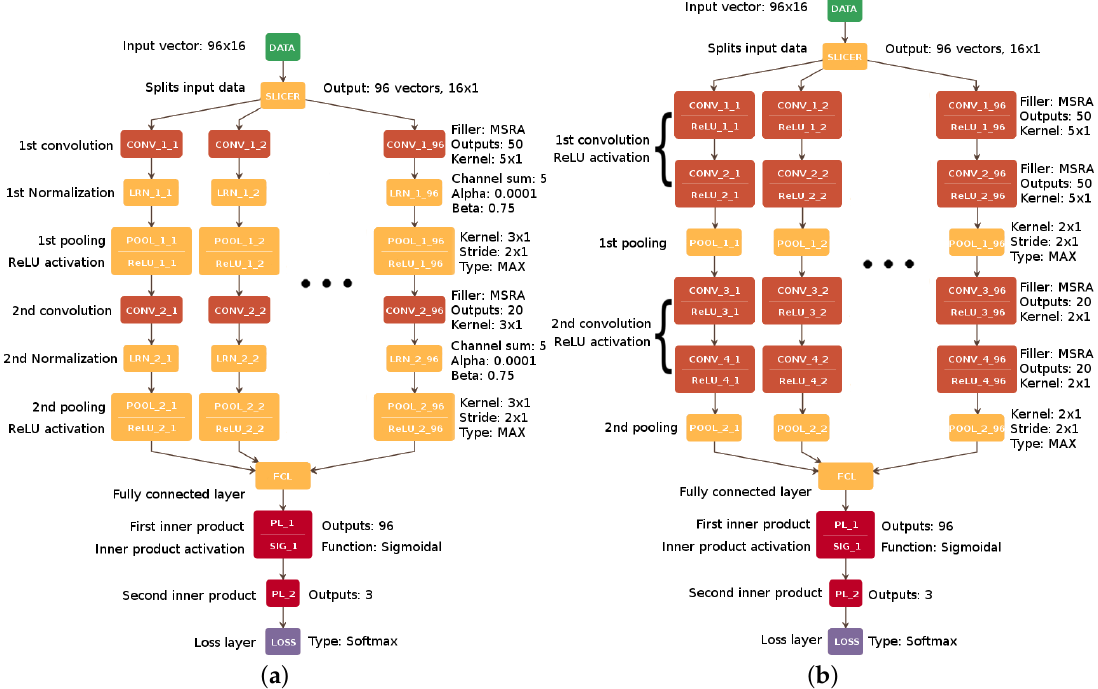
Figure 4. The AlexNet multichannel variation developed for the architecture comparison and performance analysis ( a ); and the VGG-16 multichannel variation developed for the architecture comparison and performance analysis ( b